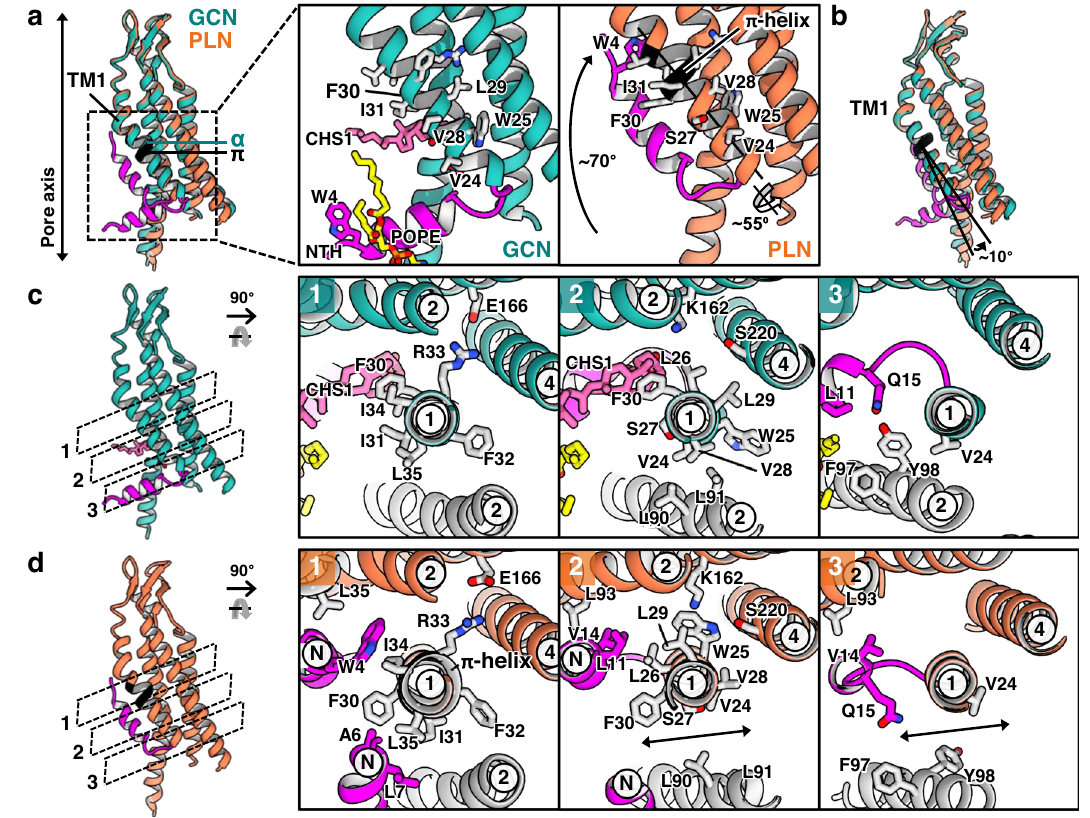
Fig. 5 | Conformational changes of NTH and the α -to- π helix transition in the TM1 during the conversion of GCN to PLN. a Structural alignment of Cx43-M257 protomersinGCNandPLNconformations(left).The α -and π -helicesofprotomers in the GCN and PLN conformations are labeled, respectively. Close-up view of the boxedregion(right).MovementsofNTHandrotationsofTM1areindicatedbyone- way arrows. Residues in TM1 and W4 are drawn as sticks and labeled. The lipids in